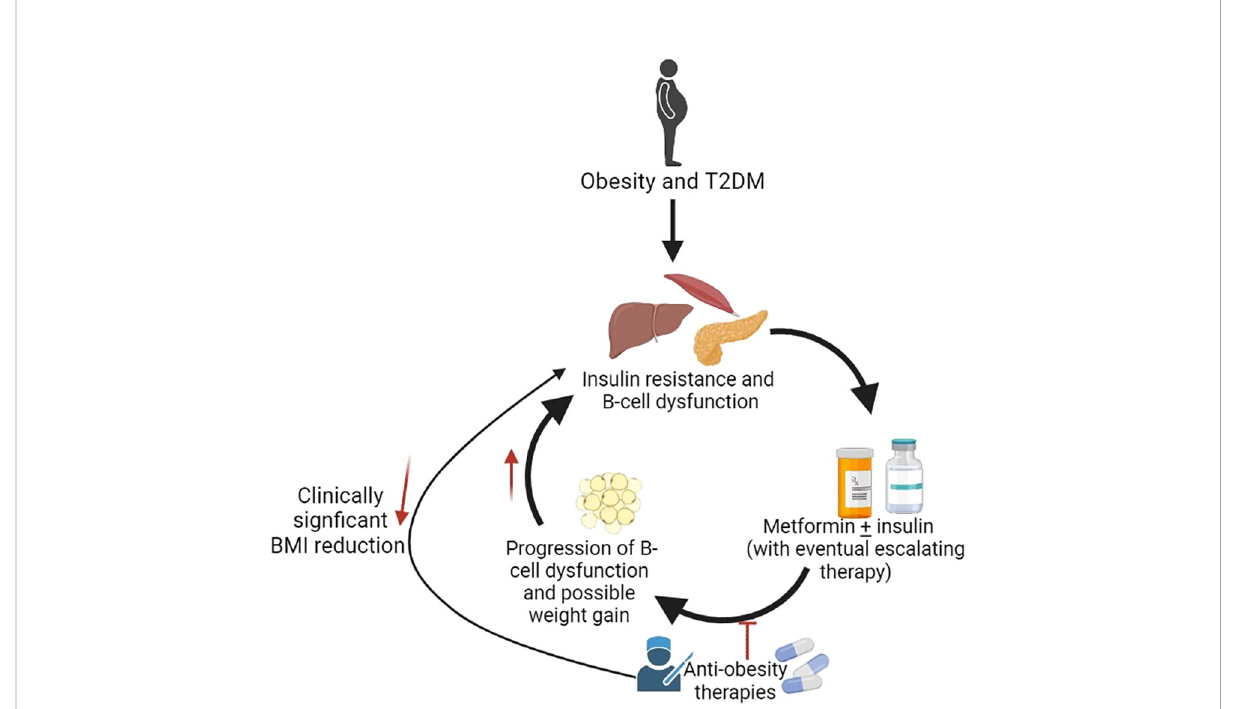
FIGURE 1 Potential role of anti-obesity medications in treatment of T2DM. Created with